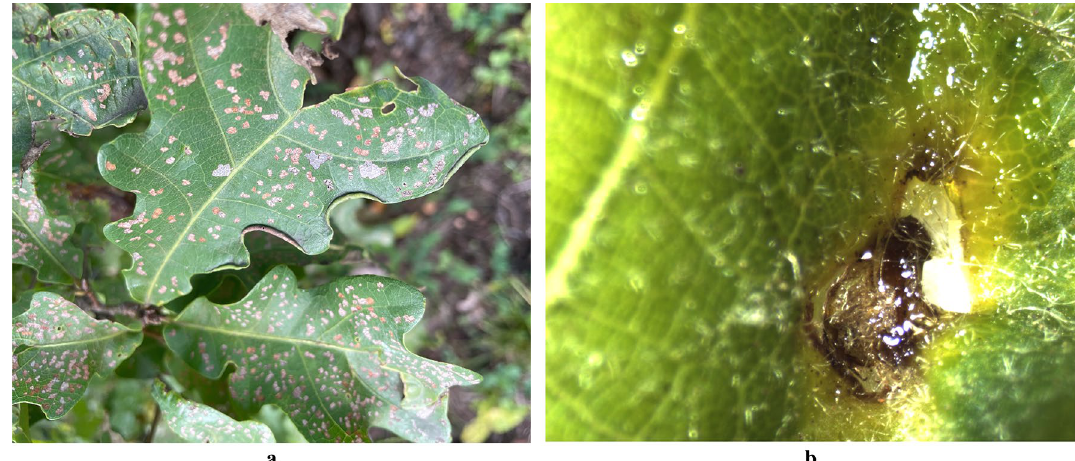
Figure 7. Damage symptoms caused by adults of Rhynchaenus maculosus. ( a ) Damage caused by summer adults; ( b ) Damage caused by spring